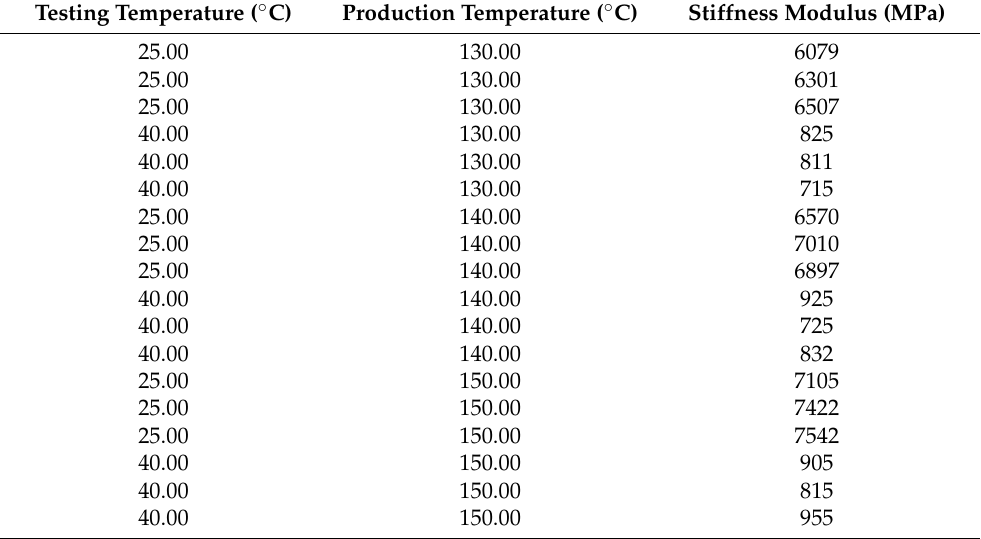
Table 4. Input data of the stiffness modulus